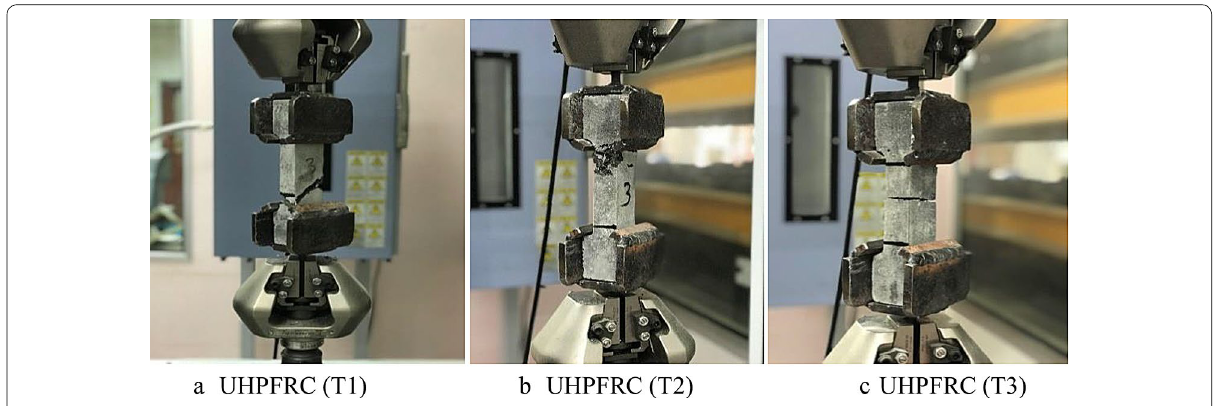
Fig. 15 Formation of macro crack and post peak failure of the uniaxial tensile